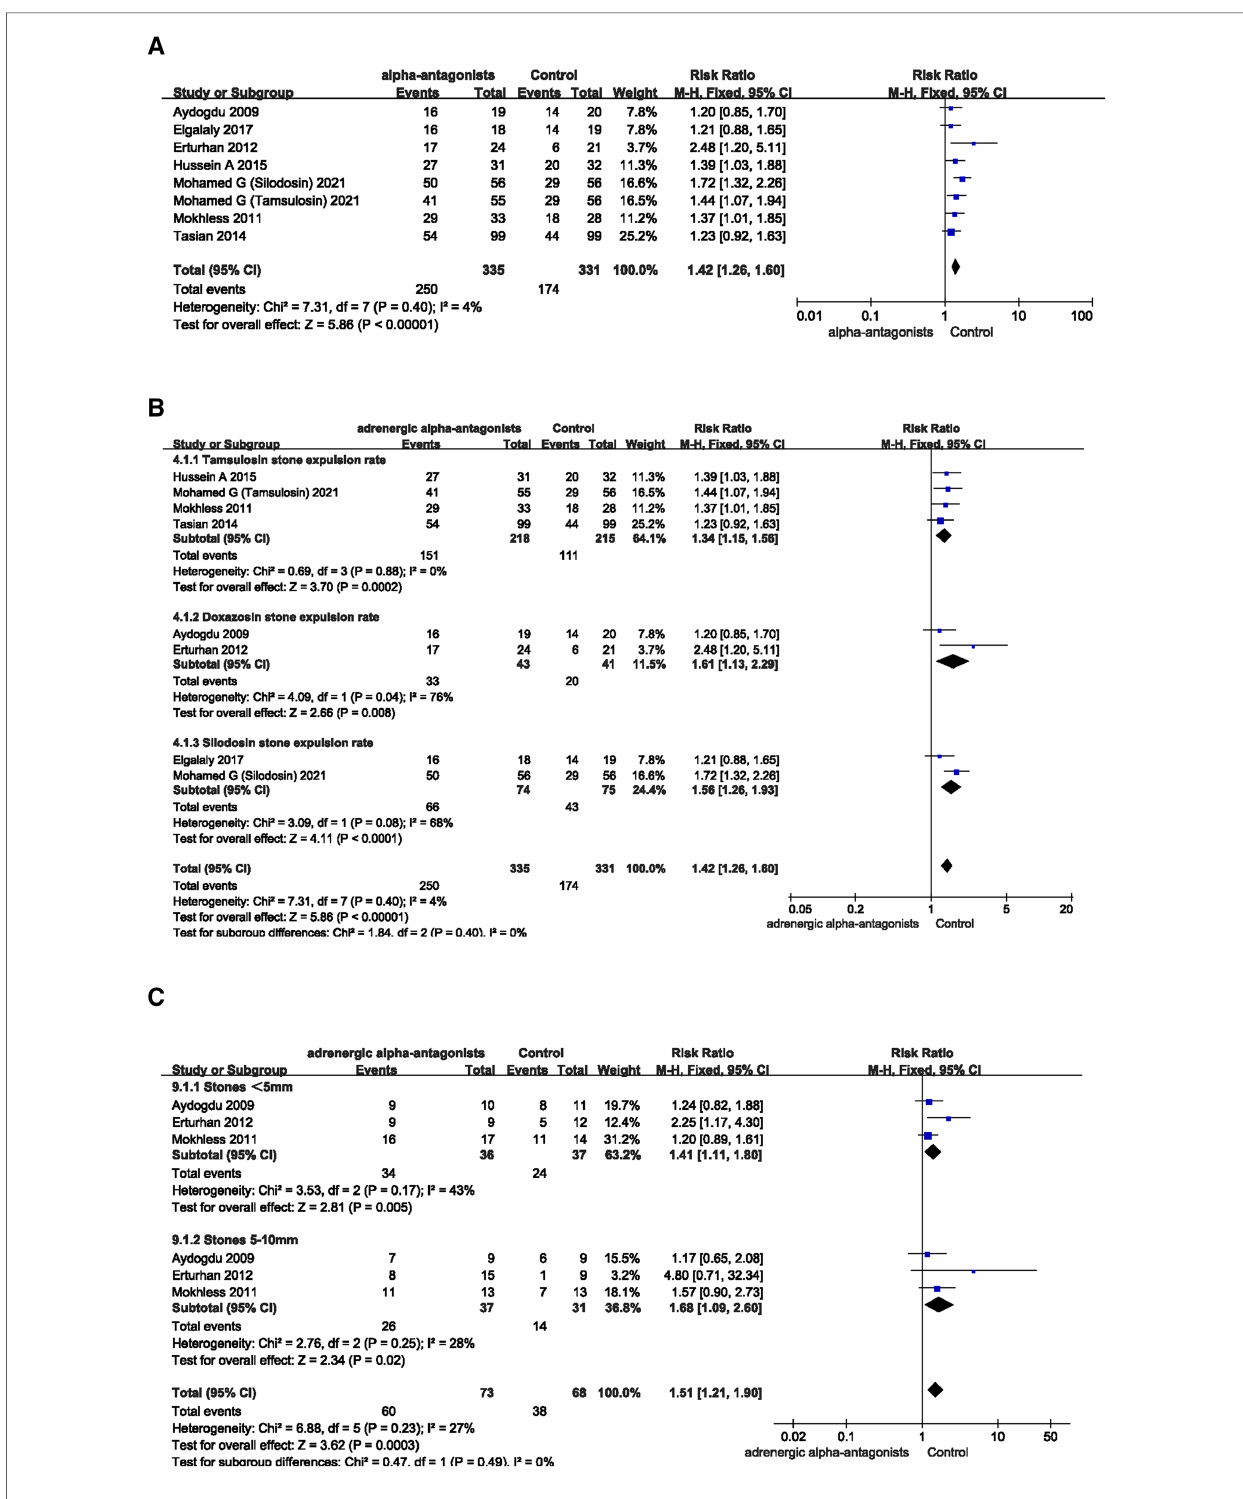
FIGURE 3 Forest plot comparing changes in ureteral calculi expulsive rate between adrenergic alpha-antagonists and control groups. ( A ) Effects of treatment with adrenergic alpha-antagonists on ureteral calculi expulsive rate compared with control group. ( B ) Subgroup analysis of the effects of adrenergic alpha- antagonists on the ureteral calculi expulsive rate. ( C ) Subgroup analysis of the effect of adrenergic alpha-antagonists on the expulsive rate of ureteral calculi of different